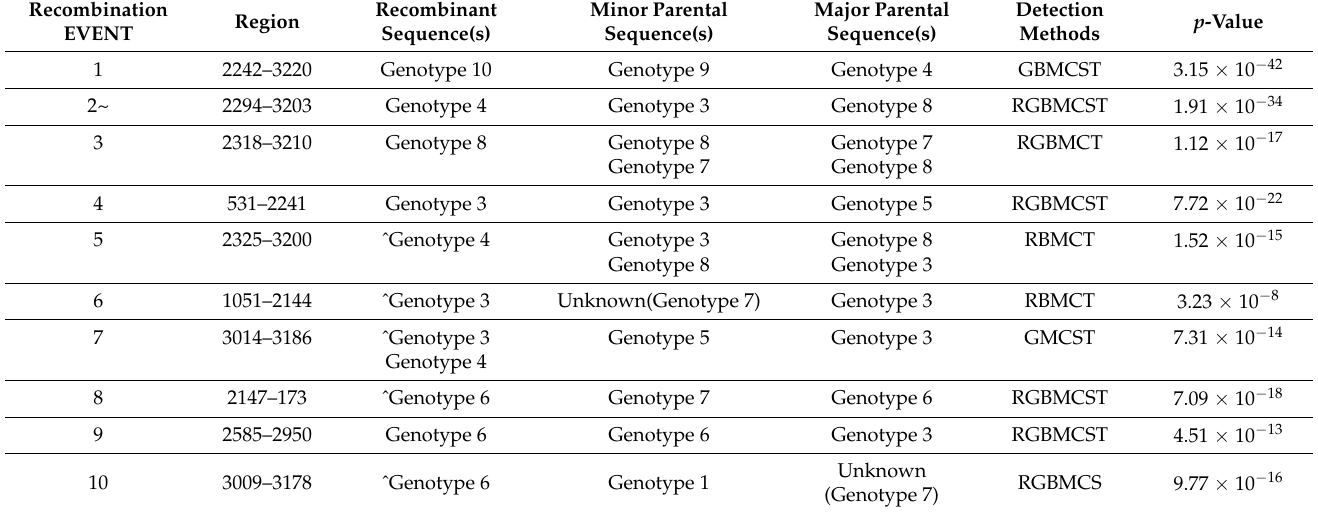
Table 2. Summary of the 21 recombination events detected in the OpV2 sequences by RDP5 v5.5. The methods used to detect recombination were RDP (R), GENCONV (G), BOOTSCAN (B), MAXCHI (M), CHIMERA (C), SISCAN (S) and 3SEQ (T). The method with the highest p -value for each recombination event is bolded. Sites where the actual breakpoint is undetermined are marked with *. (T) denotes traces of recombination signals and (P) denotes partial evidence. Recom- binant sequences marked with ^ indicate that the recombinant sequence may have been misidentified (one of the identified parents might be the recombinant). Please refer to the table for accession # of the genotypes.